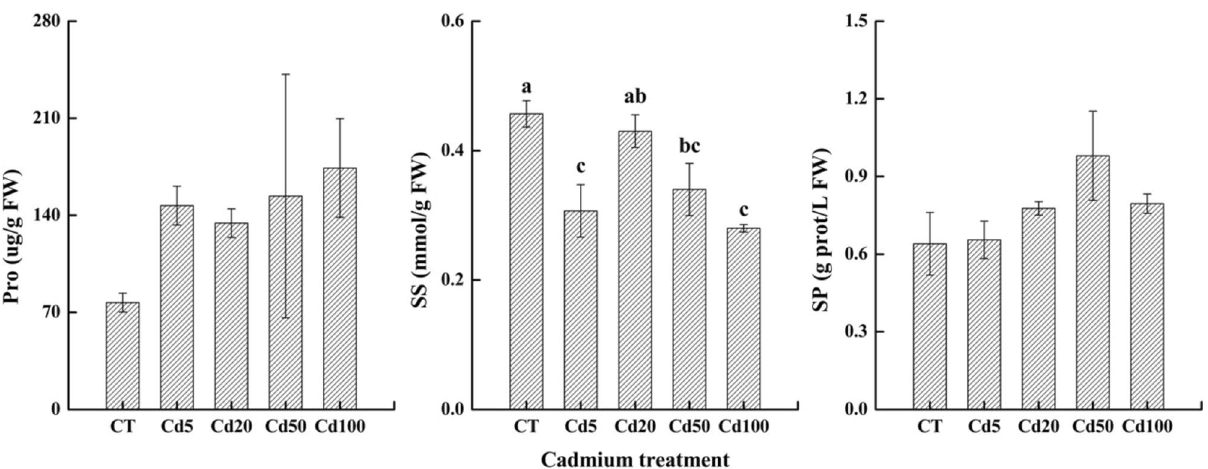
Figure 3. Changes in proline (Pro), soluble sugar (SS) and soluble protein contents (SP) in sassafras leaves under different levels of cadmium